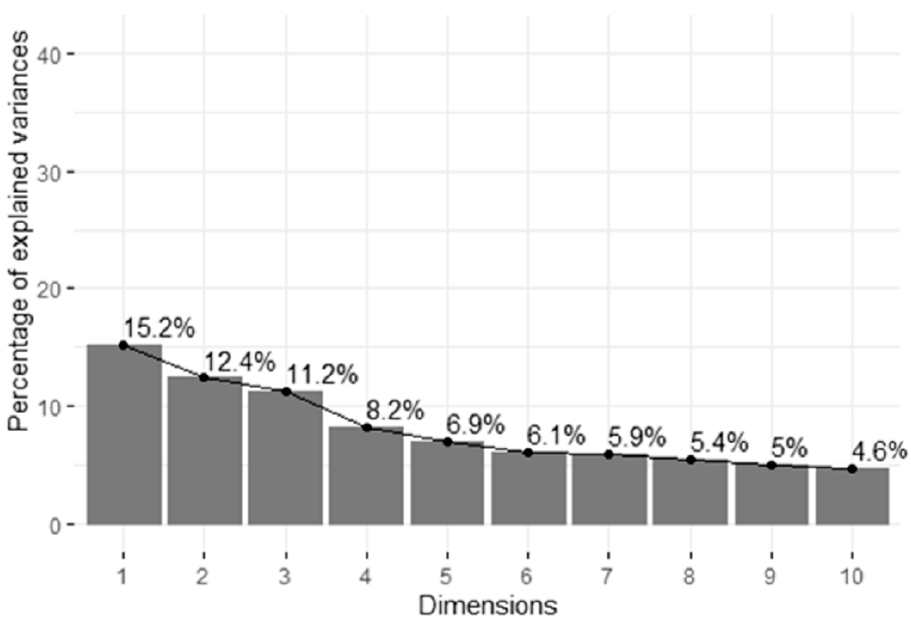
Figure 4. Scree plot with percentage of explained variances per principal component factors (di- mensions) of cluster 1.